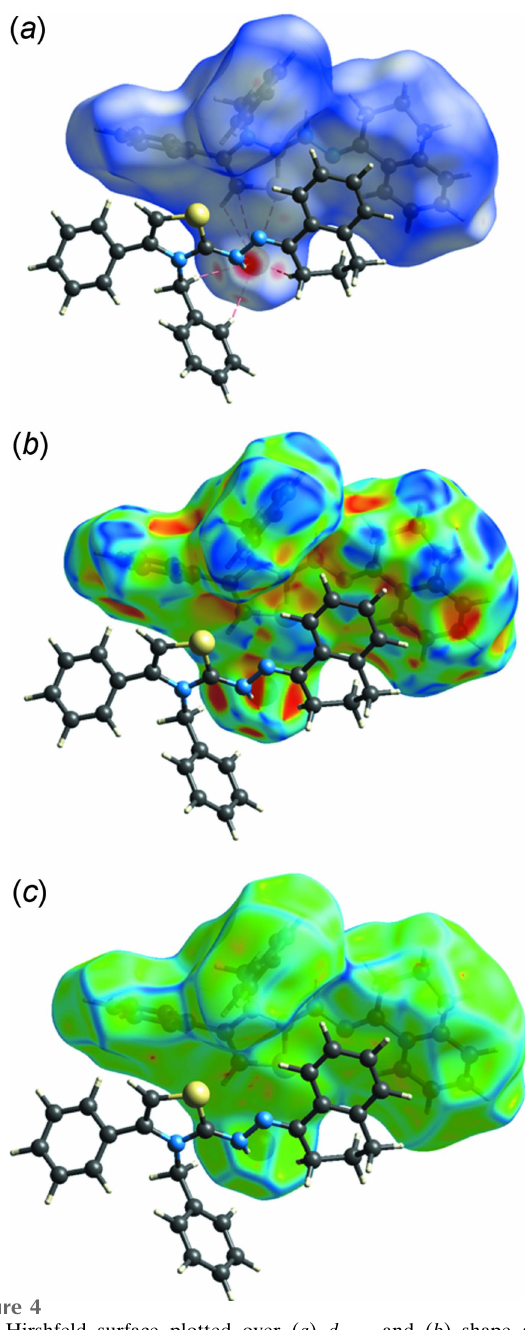
Figure 4 The Hirshfeld surface plotted over ( a ) d norm and ( b ) shape and ( c ) curvature